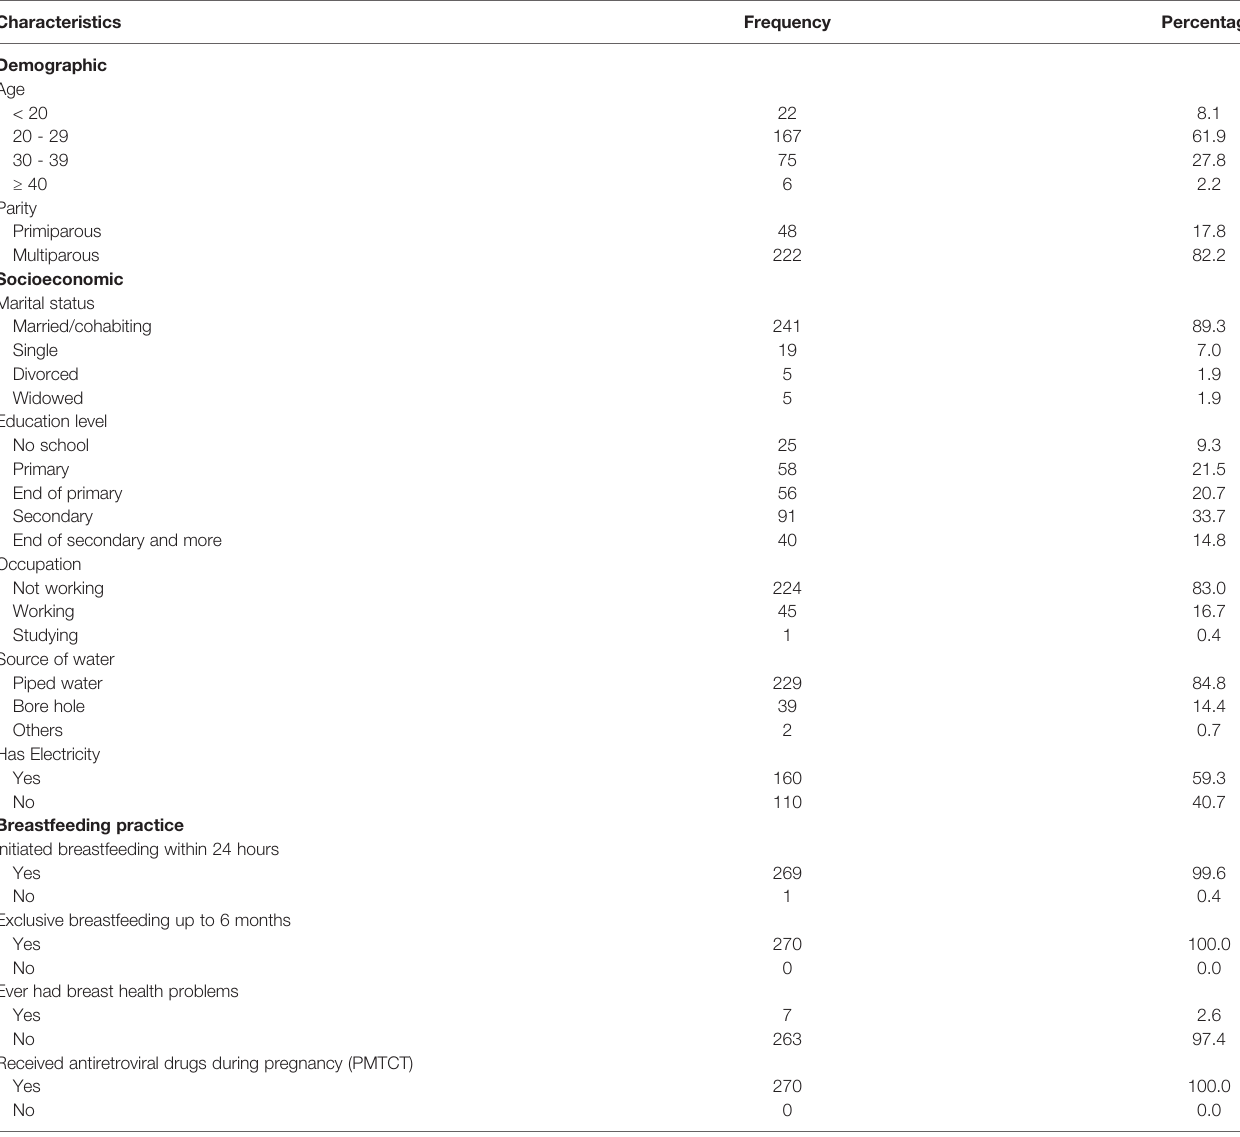
TABLE 1 | Participants ’